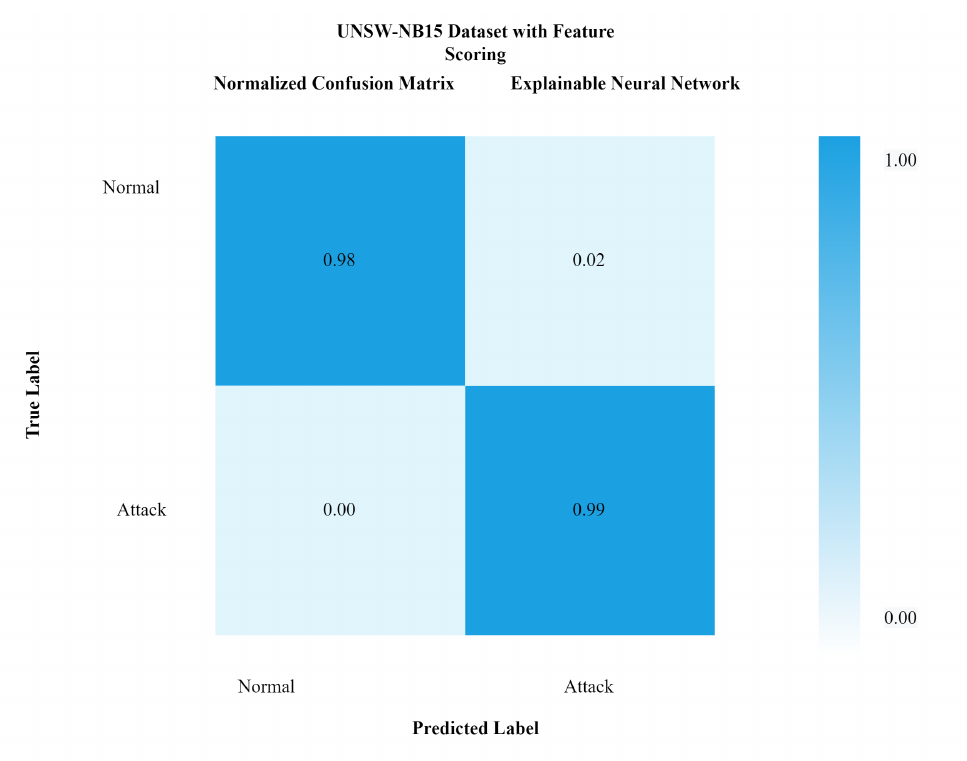
Figure 9. The performance of xNN on UNSW-NB15 without feature scoring.